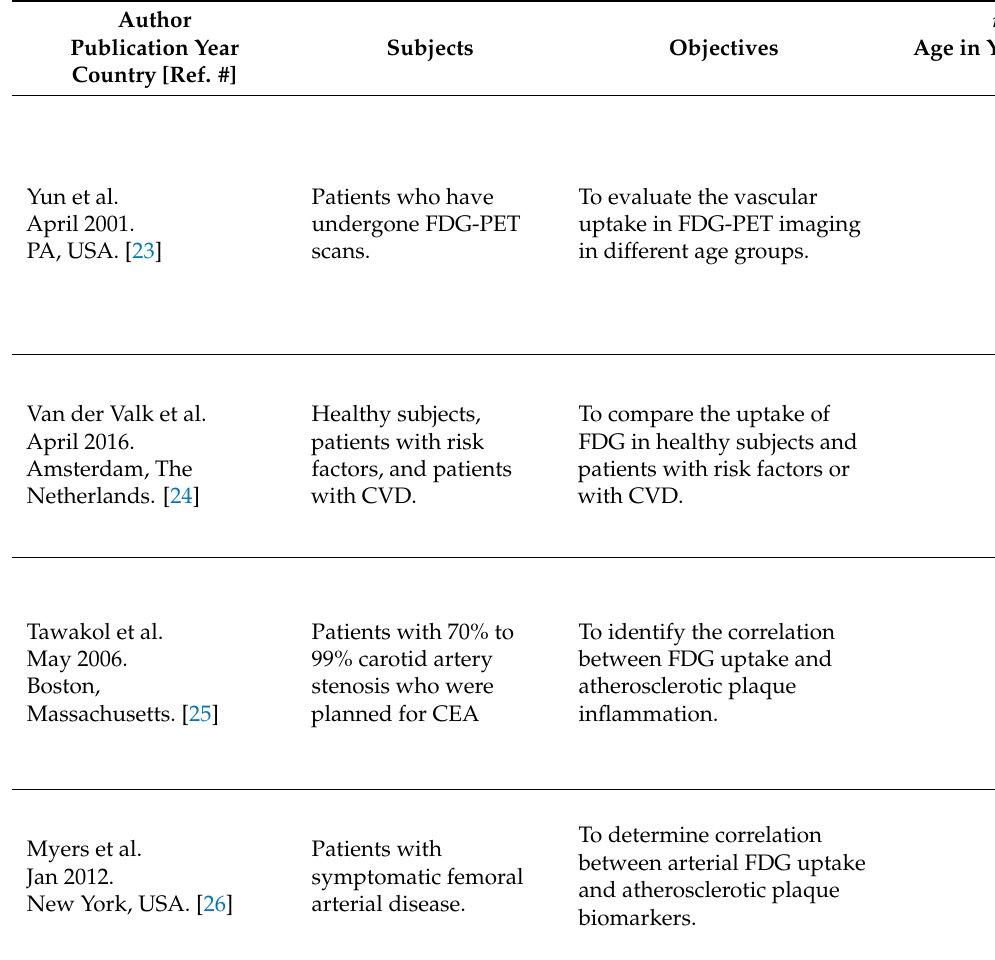
Table 1. Studies on the Role of FDG in